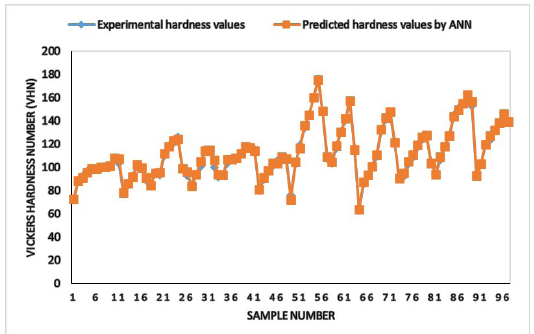
Figure 10. Hardness values comparison between experiment and prediction.